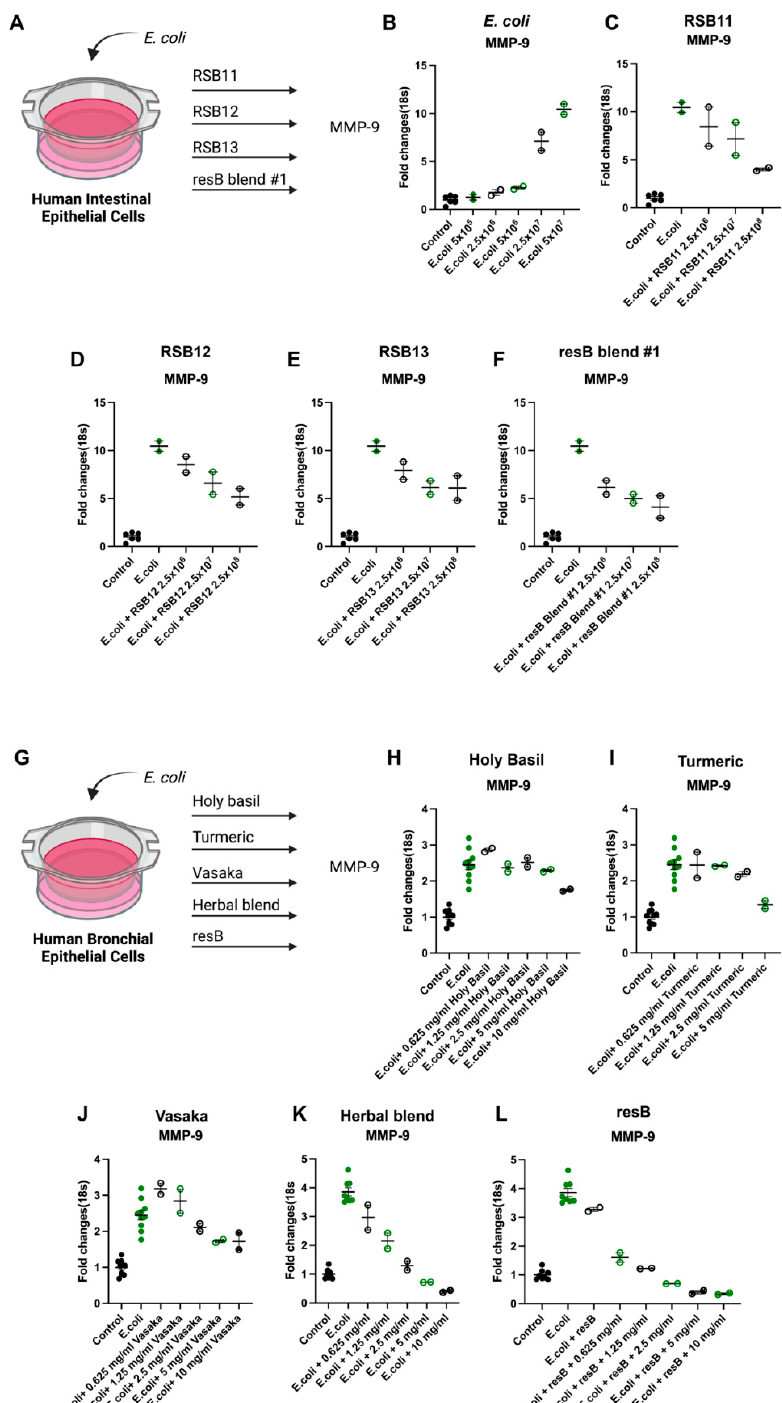
Figure 1. resB blend #1 (RSB11, RSB12, RSB13) and herbal extracts counteract neutrophilic inflam- mation via the MMP-9 pathway in human IEC and HBEC models of proteobacteria abundance in the gut and lung. ( A ) Cells were exposed to E. coli before treatment with probiotic strains. Schematic created in Biorender. ( B ) MMP-9 transcription increases upon addition of increasing concentrations of E. coli in a human intestinal cell line model of dysbiosis. ( C ) RSB11, ( D ) RSB12, ( E ) RSB13, and ( F ) resB blend #1 (RSB11, RSB12, RSB13) decrease MMP-9 in IECs exposed to E. coli. ( G ) Cells were exposed to E. coli before treatment with increasing dosages of ( H ) holy basil, ( I ) turmeric, ( J ) vasaka, ( K ) herbal extract blend, or ( L ) resB blend #1 probiotic blend (RSB11, RSB12, RSB13) with increasing dosages of herbal extract blend that each led to decreases in MMP-9.